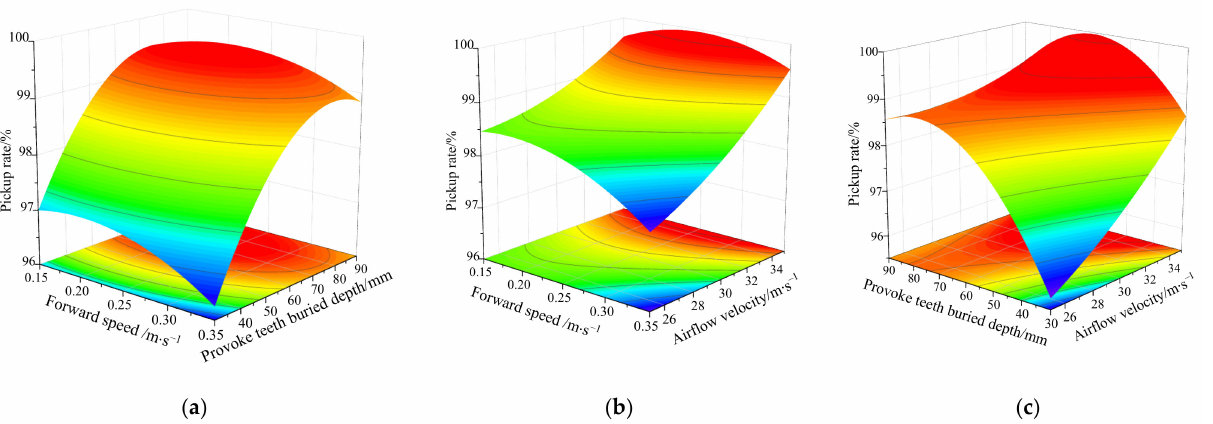
Figure 7. Interaction factors effect on the pickup rate: ( a ) interaction factors between the forward speed and the provoke teeth buried depth, ( b ) interaction factors between the forward speed and the airflow velocity, and ( c ) interaction factors between the provoke teeth buried depth and the airflow